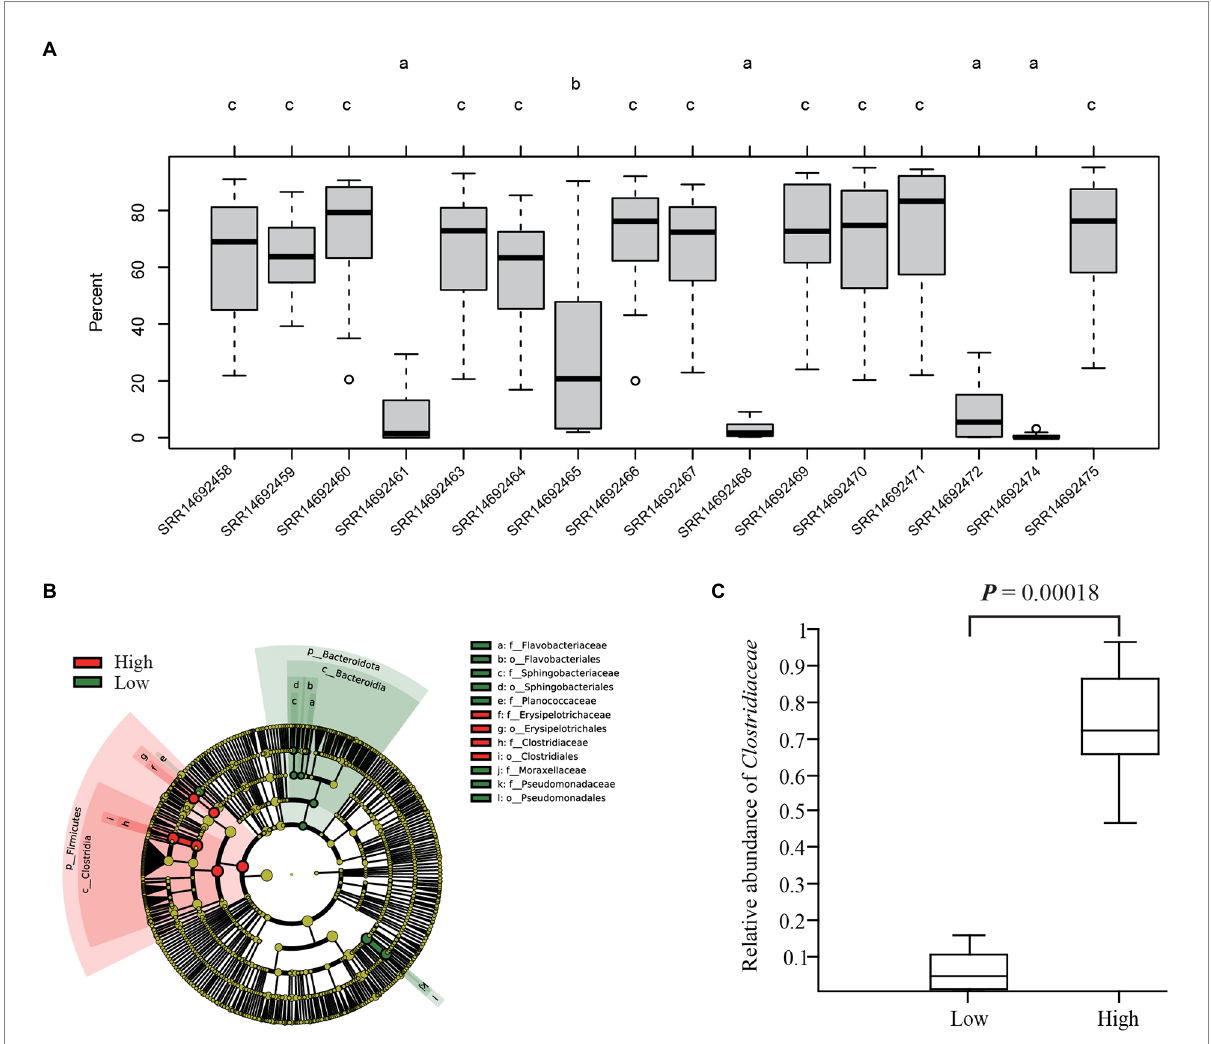
FIGURE 4 Differential abundance analyzes among the 16 giant panda donor microbiota from Huang et al. (2022). The comparisons of the proportions of 16 original giant panda fecal microbiotas in GF mice on 14 th or 21 st day after FMT with source tracking analysis indicated that the differences among 14 th or 21 st day were same (Supplementary Figure S12) and only results for the 21 st day are shown in (A) . Four fecal microbiotas had proportions lower than 25% (indicated by the letter a) and the proportions of the other 11 original fecal microbiotas were significantly higher (indicated by the letter c). Different letters indicate significant differences ( p -value < 0.05; One-way ANOVA with post-hoc Tukey’s HSD test). Thus, the four samples (letter with a) were indicated with low percent group and the 11 samples (letter with c) with high percent group. The results of LEfSe analysis between the low and high percent groups is shown in (B) . Here Clostridiaceae showed significant difference between low and high groups. The relative abundance analysis of Clostridiaceae of 16 giant panda donor microbiota (including the 15 samples from panel (A) and our 1 sample in this study) between the low and high groups is shown in (C) ( t